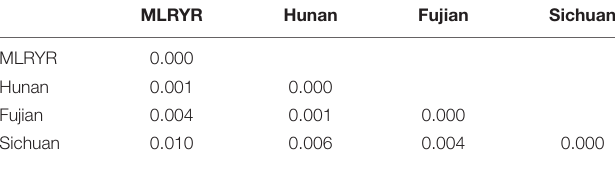
MLRYR Hunan Fujian